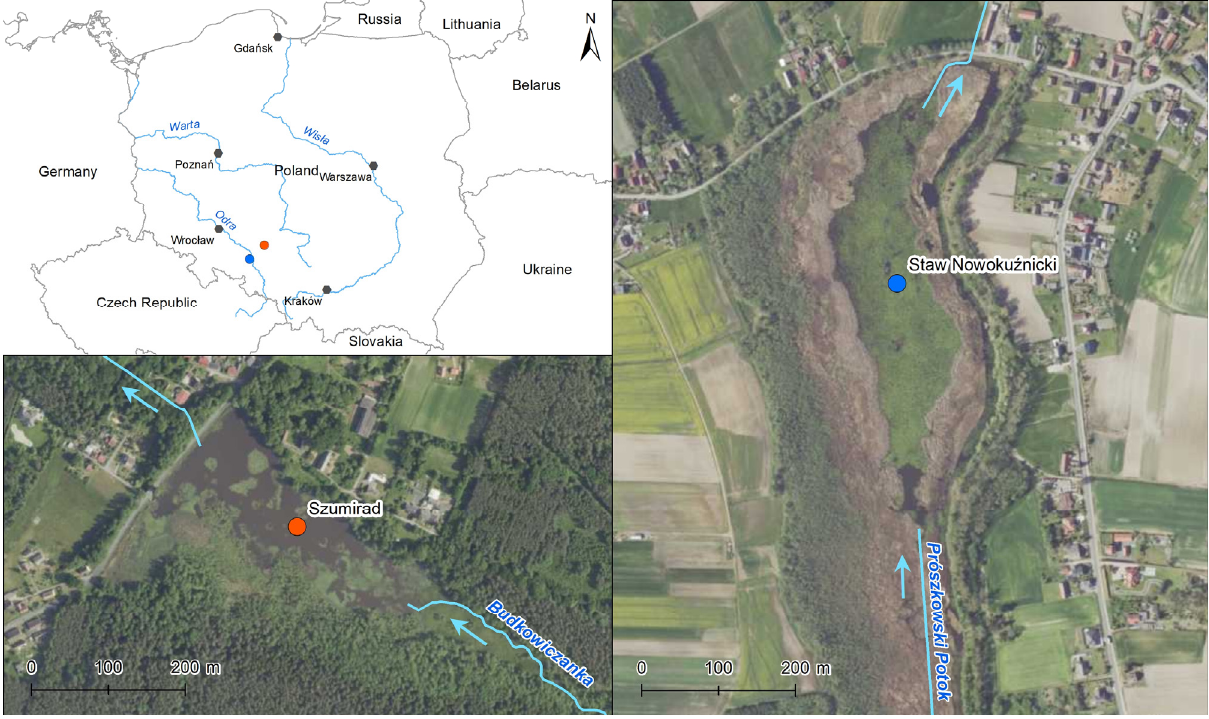
Figure 1. Location of the studied